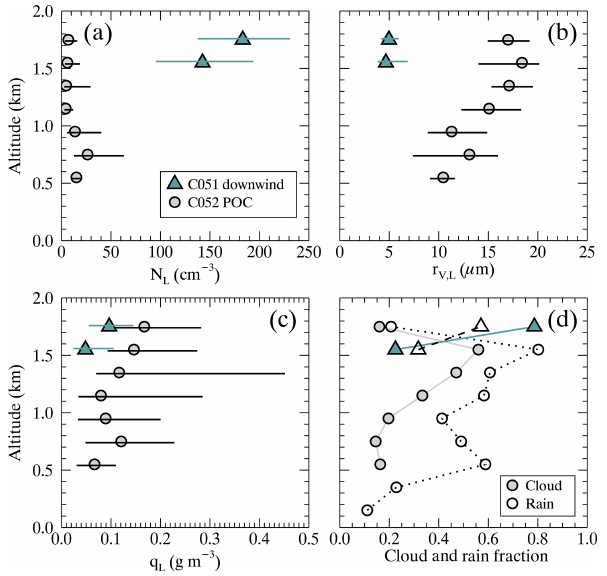
Figure 11. Composite vertical profiles of (a) rain drop number con- centration, (b) volume mean radius of rain drops, (c) rain water con- tent and (d) rain rate. The filled symbols are the median and the hor- izontal bars the interquartile range of the in-rain data. Data points containing rain are defined when the concentration of drops larger than 60µm exceeds 1L − 1